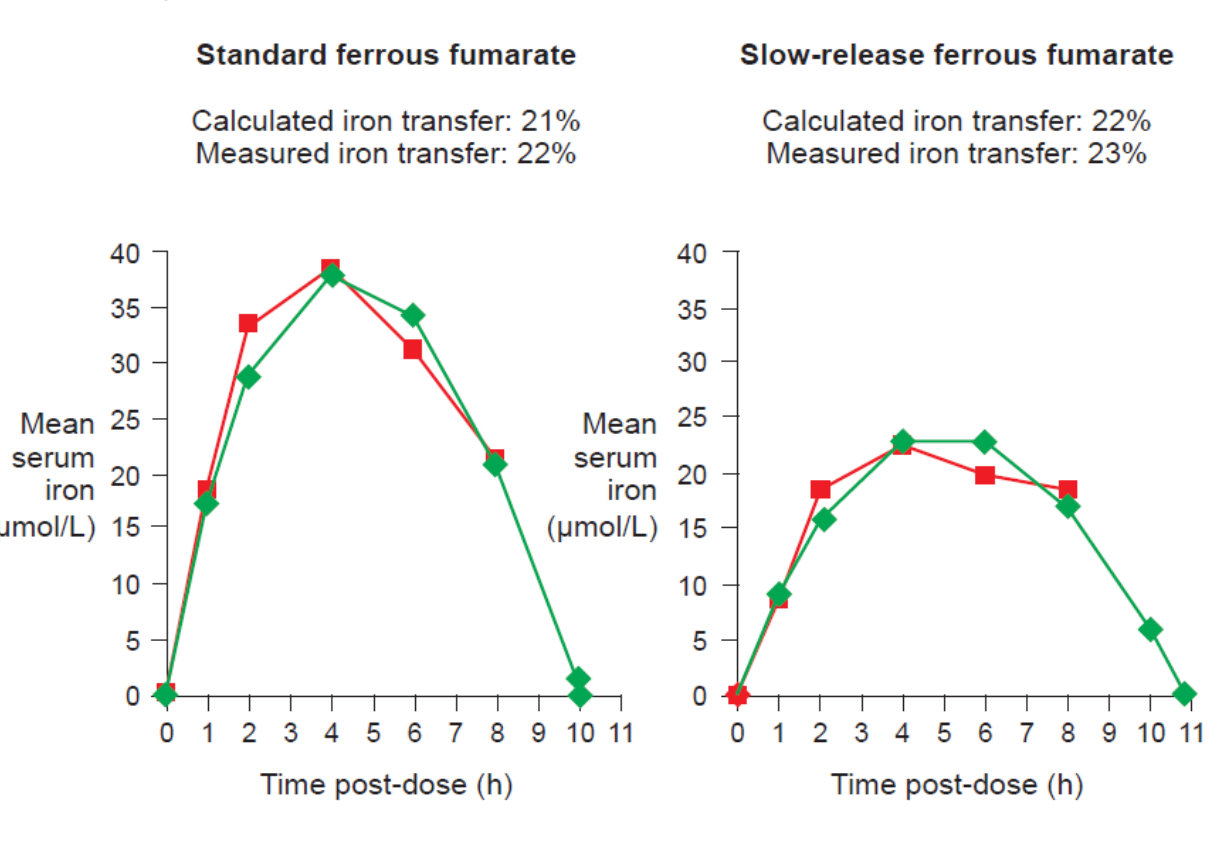
calculated curve (green lines) based on the following equation: C(t) = a (1−e −kin*t ) – k